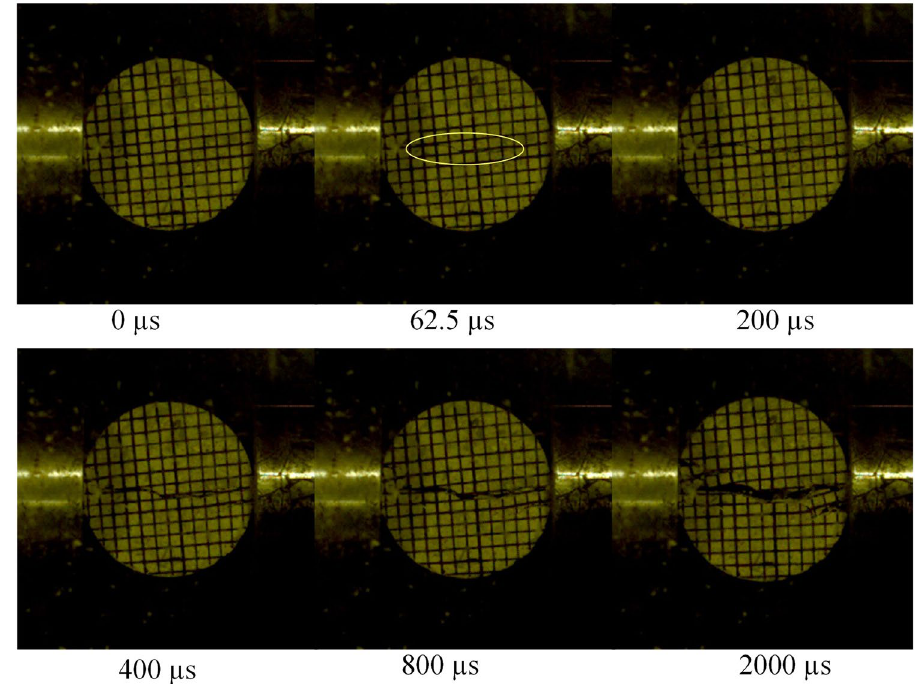
Figure 12. High speed camera snapshots during the failure process of concrete BD specimen